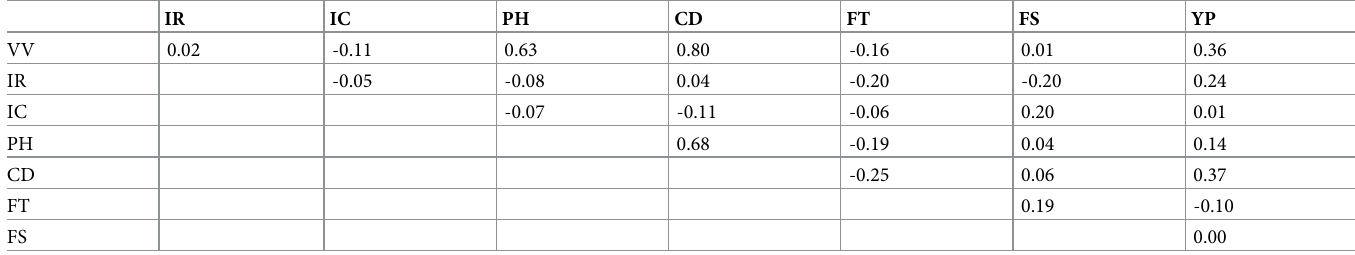
Table 6. Genotypic correlation among the following traits: Vegetative vigor (VV), incidence of rust (IR), incidence of cercosporiosis (IC), plant height (PH), canopy diameter (CD), fruit ripening time (FT), fruit size (FS), and yield per plant (YP), evaluated in the robusta coffee population. IR IC PH